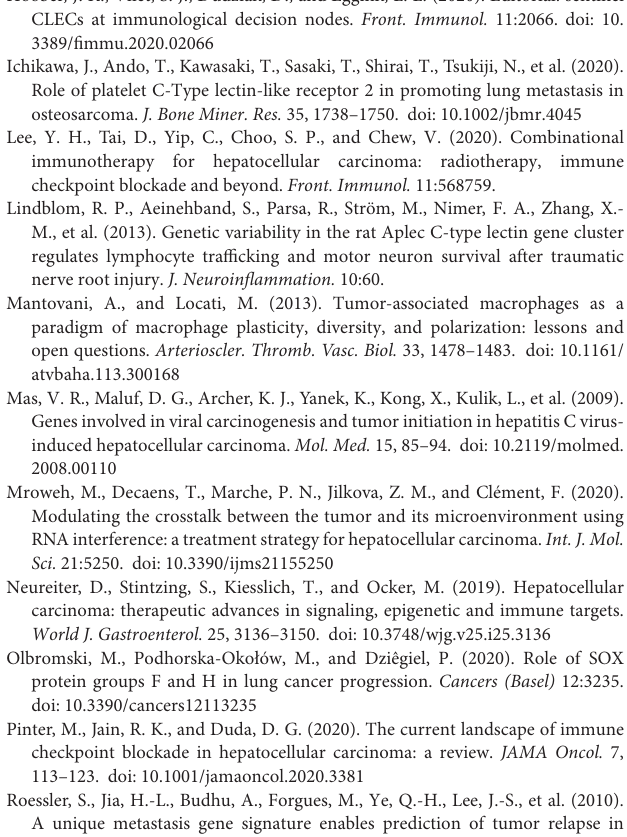
Supplementary Figure 9 | Schematic representation of the overall workflow of this research. The flow chart summarized the overall steps for the target gene identification and analysis. Supplementary Table 1 | The potential COVID-19 related gene sets associated with CLEC4. Supplementary Table 2 | The predicted drugs targeting CLEC4s for treating COVID-19 based on Drug matrix. Supplementary Table 3 | qPCR primers used in this study. Supplementary Table 4 | The correlation between CLEC4s and liver cancer drug targets. Supplementary Table 5 | The expression level of CLEC4s in hepatocarcinoma cell lines. Supplementary Table 6 | Characteristics of patients with HCC based on TCGA. Supplementary Tables 7–17 | Relationship between CLEC4s mRNA expression and clinical characteristics in